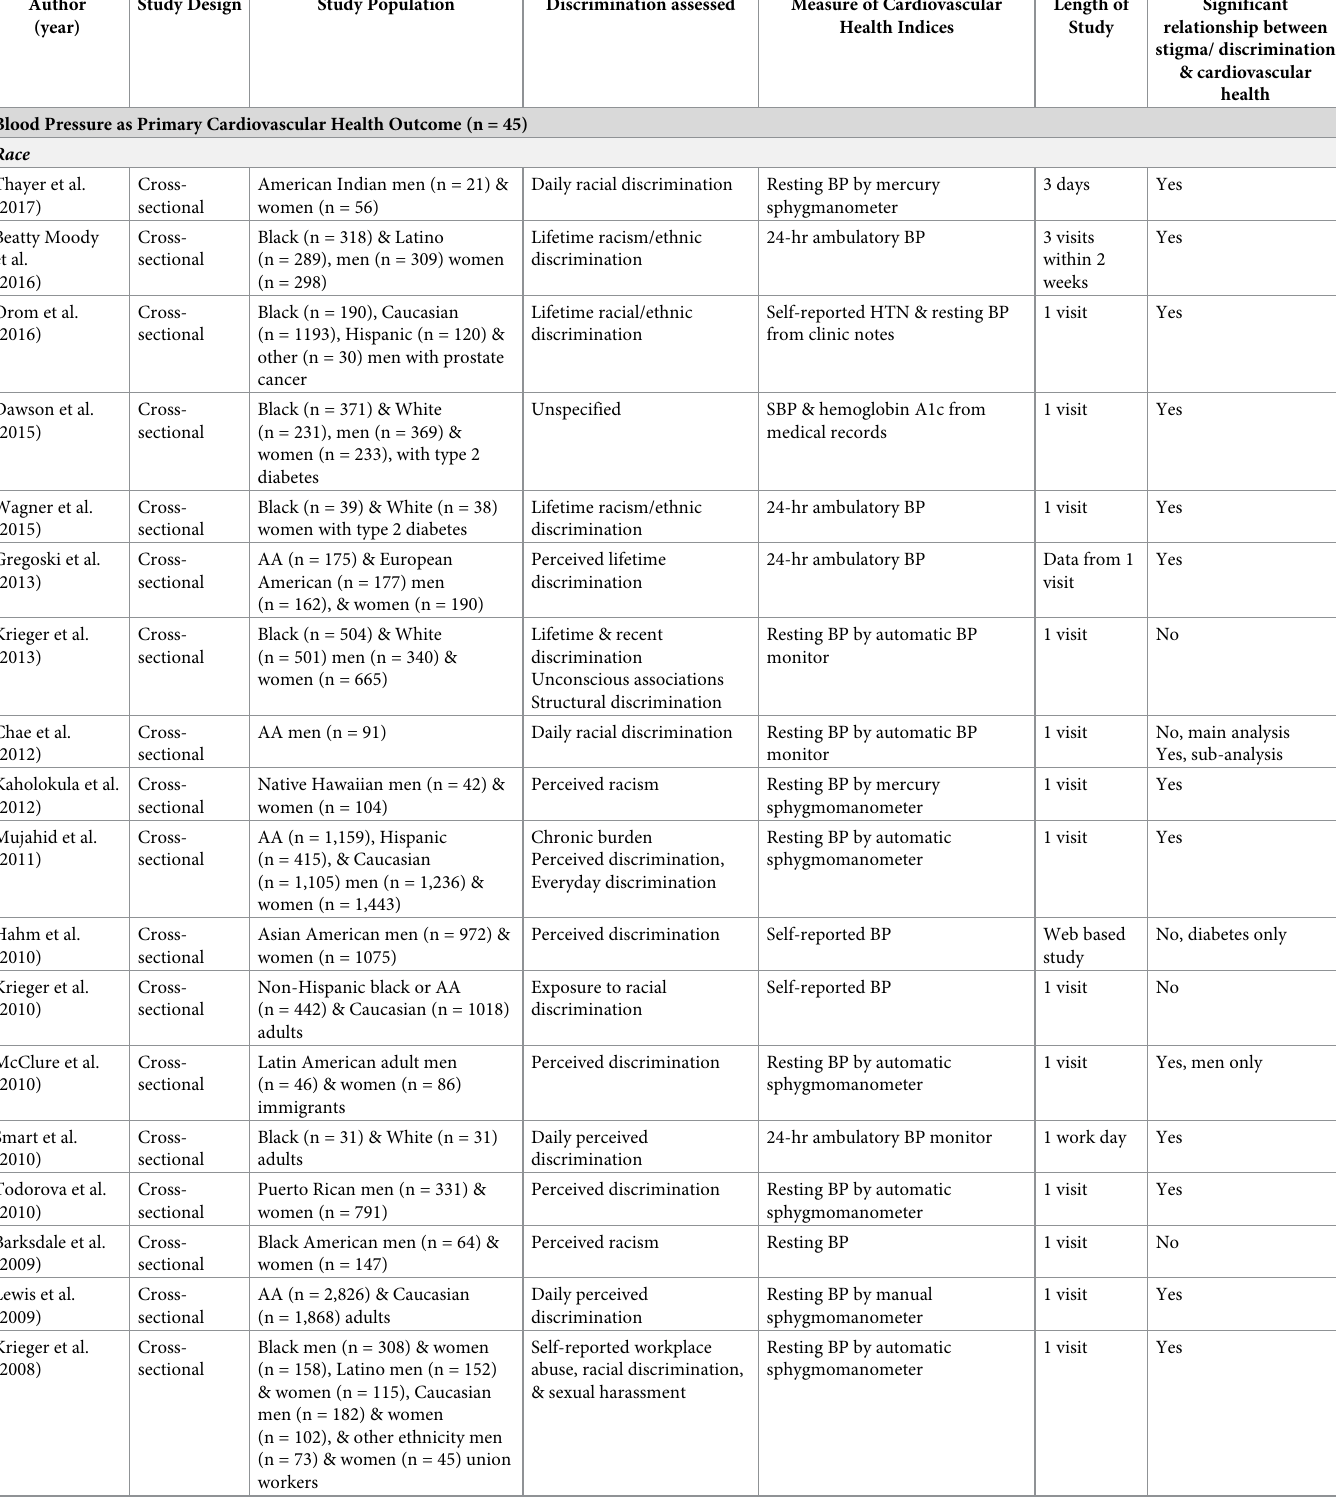
Table 2. Characteristics of studies (N = 84) examining the relationship between stigma/discrimination and cardiovascular health outcomes among common socially stigmatized groups. Author